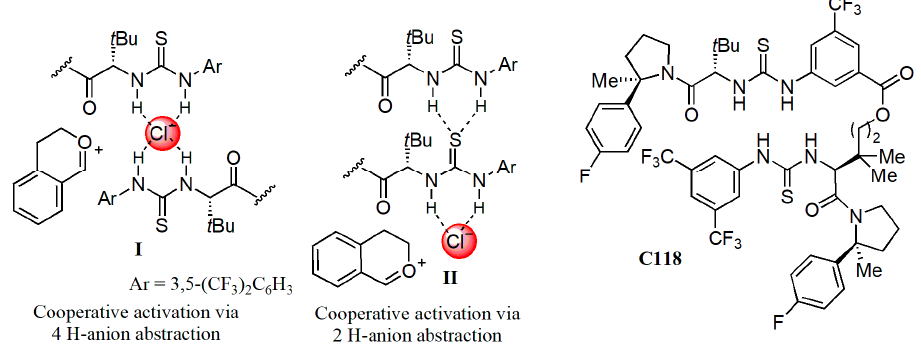
Figure 48. Anion-abstraction catalysis via the cooperative action of two amido-thioureas and catalyst C38 [93]. The kinetic resolution of racemic amines via acylation and other methods is an im- portant means to obtain chiral amines for various applications. The utilization of small- molecule catalysts for resolution is still challenging, in contrast to enzymatic methods, and only recently have solutions started to appear, which nevertheless, are not as advanced